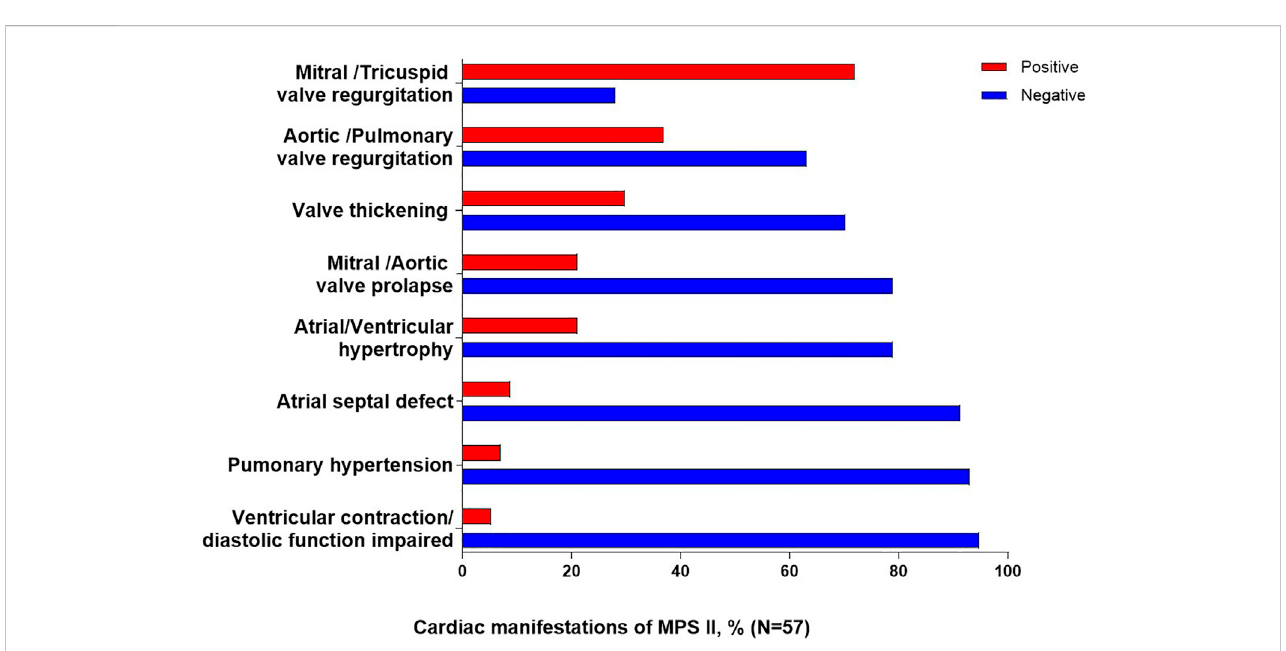
FIGURE 1 Cardiac clinical manifestations of MPS II. Percentages are calculated as a proportion of the total patients who underwent cardiac ultrasound (N =